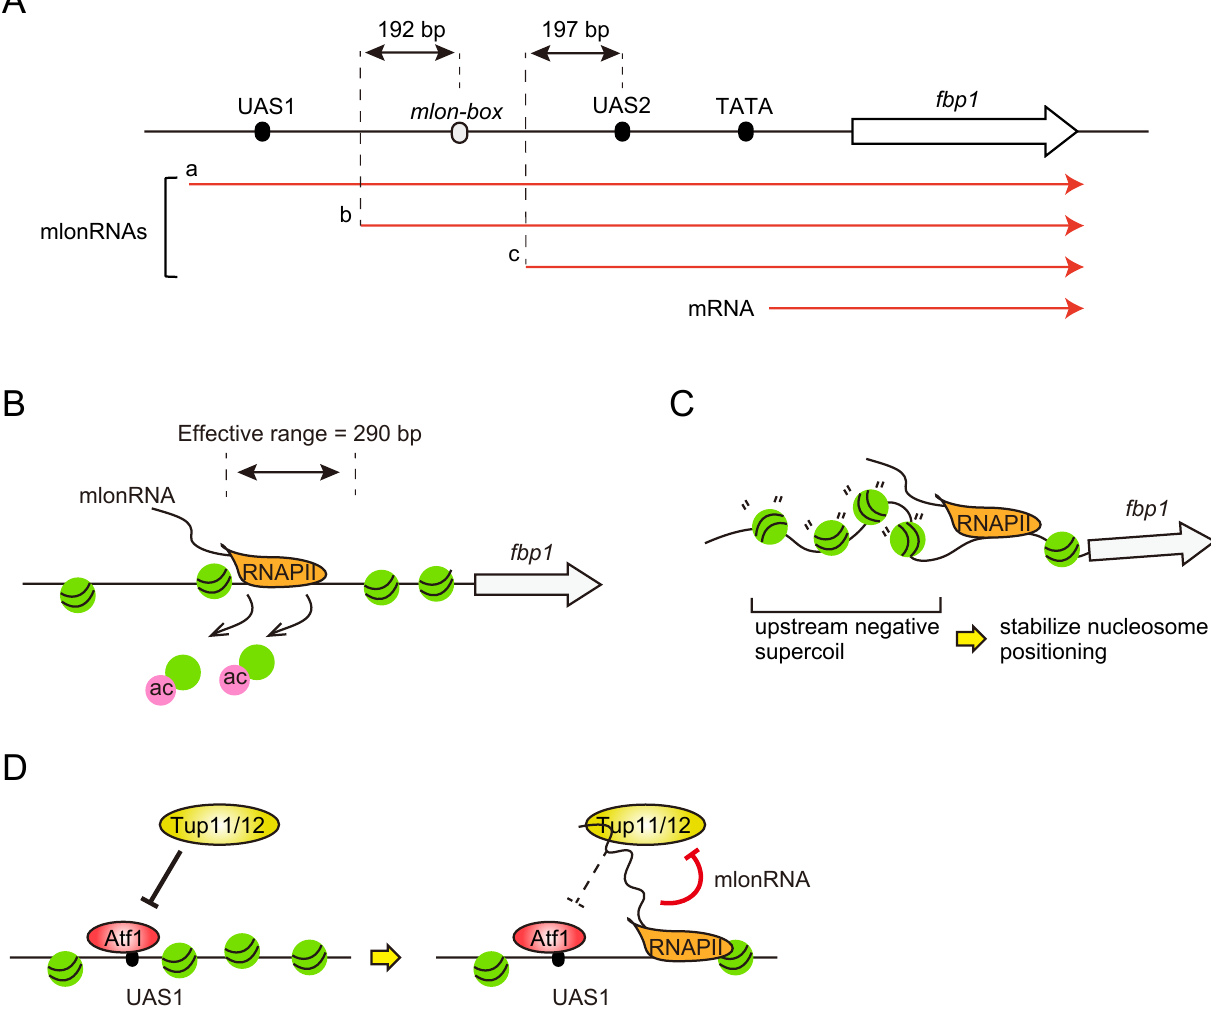
Figure 3. mlonRNA-transcription-mediated regulations of chromatin structure and transcription factor binding. ( A ) Schematic representation of lncRNAs transcribed from fbp1 locus. In glucose rich condition, the longest mlonRNA (mlonRNA–a) are weakly expressed. At the early time of glucose starvation (10–20 min of glucose starvation), mlonRNA–b and –c are progressively expressed.